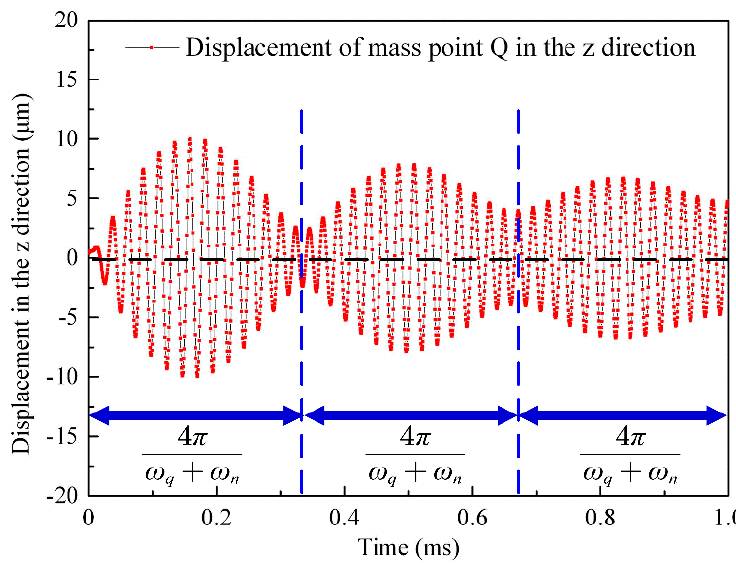
Figure 16. Displacement variation curve for the vertical direction.